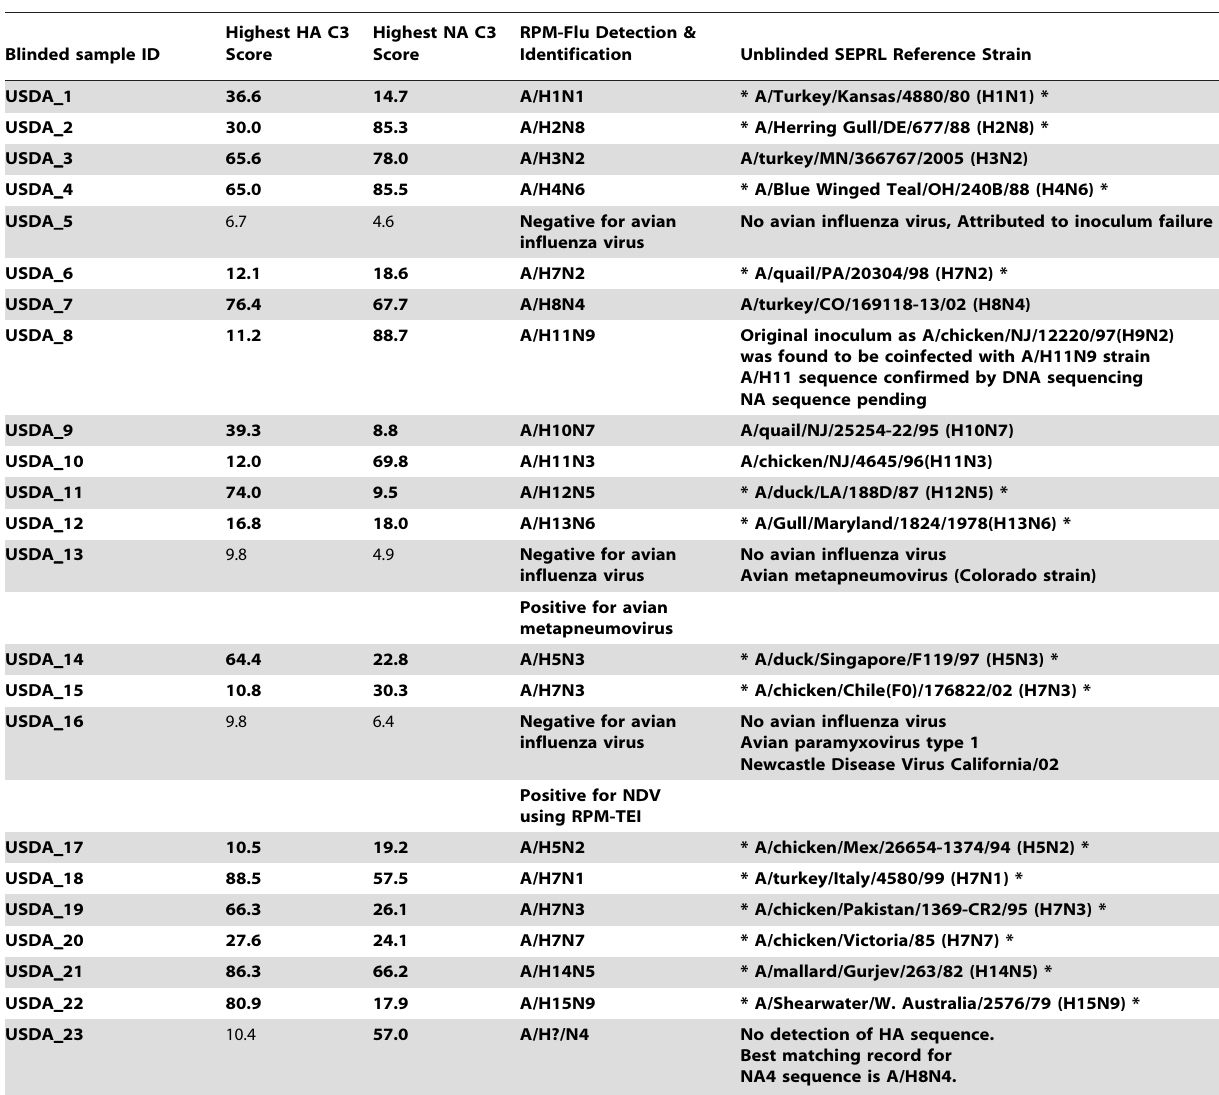
Table 6. RPM-Flu Assay detection and subtype identification of avian influenza in reference strain specimens provided by SEPRL.